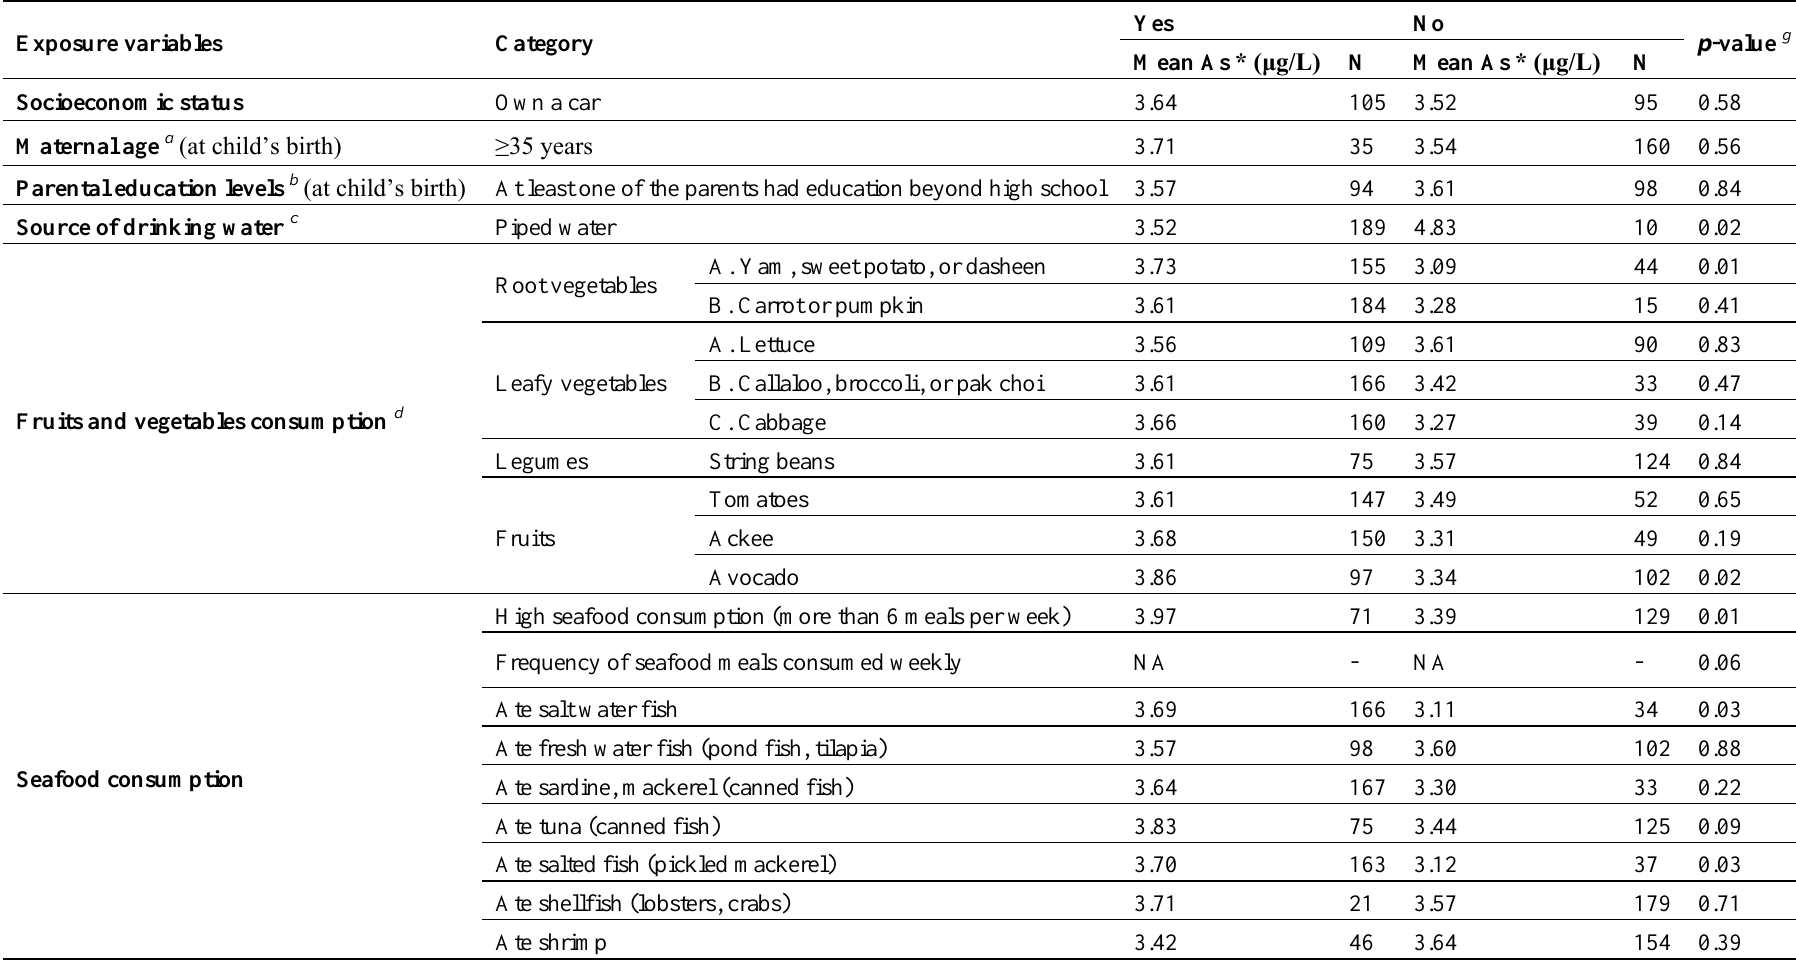
Table 3. Associations of various exposure variables with blood arsenic concentrations based on univariable General Linear Models (100 matched